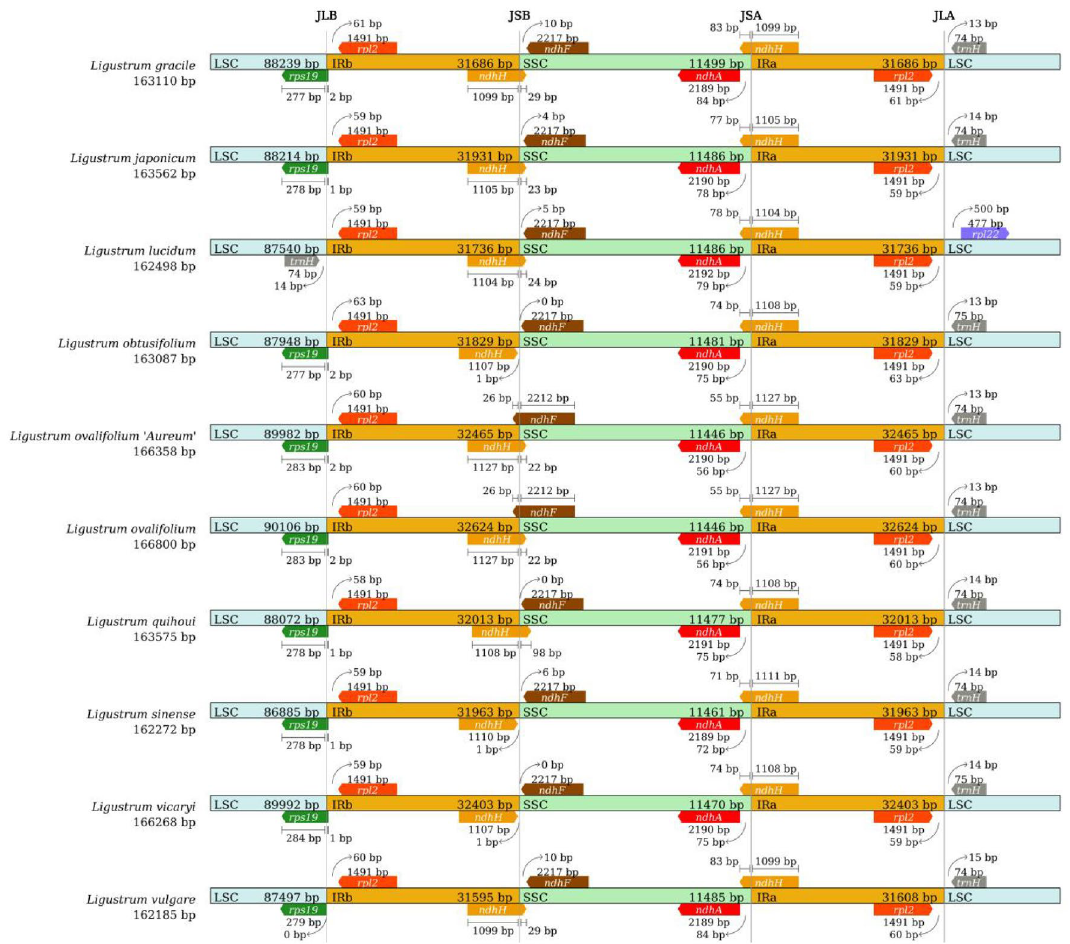
Figure 4. Comparison of the borders of large single-copy (LSC), small single-copy (SSC), and inverted repeat (IR) regions among ten Ligustrum chloroplast